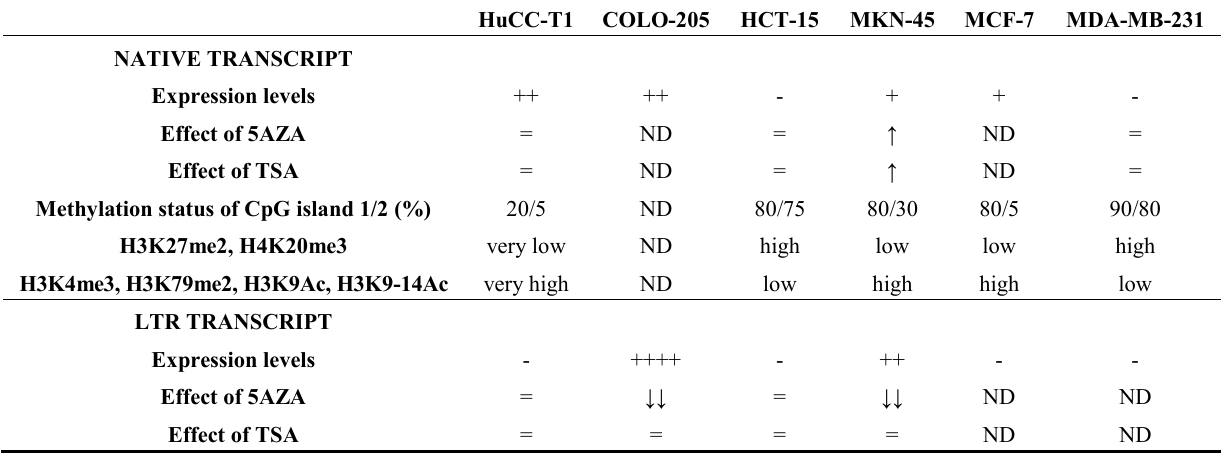
Table 1. Epigenetic features affecting B3GALT5 transcripts in various cell